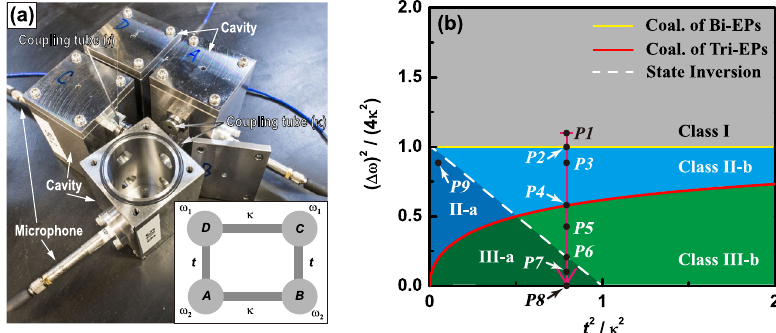
FIG. 2. (a) A photograph of four coupled acoustic cavity resonators (labeled A − D in the inset, which shows a schematic drawing of the system). Here, A and B ( C and D ) form a pair with resonant frequency ω 2 ( ω 1 ), with κ and t being the coupling between these resonators. Phase diagram in the Δ ω ∼ t space is shown in (b), with Δ ω ¼ ω 1 − ω 2 . In (b), the gray, blue, and green regions represent classes I, II, and III EPFPs, respectively. The solid red curve marks the coalescence of three EPs, the solid yellow line marks the coalescence of two EPs, and the white dashed line marks the state inversion line that separates subclasses “ a ” and “ b ” with different topological characteristics. The vertical red arrow line and the nine points (labeled from P 1 to P 9 ) are drawn to show the EPFP in Fig.